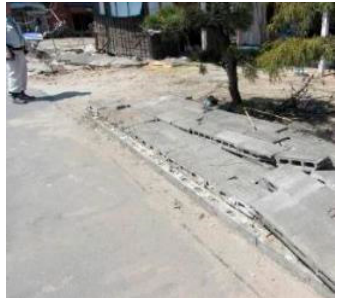
Figure 27. Block wall, inundation depth 2 m, wall fail, Kitaibaraki City.